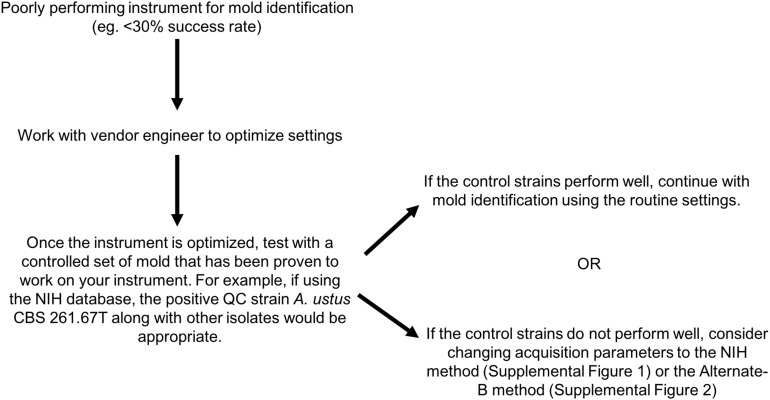
Optimization guide for laboratories experiencing low-level performance for mold identification by MALDI-TOF MS.